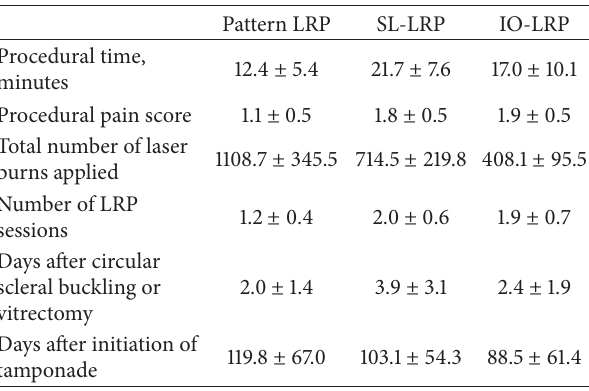
Table 3: Comparison of primary endpoints between pattern LRP, SL-LRP, and IO-LRP